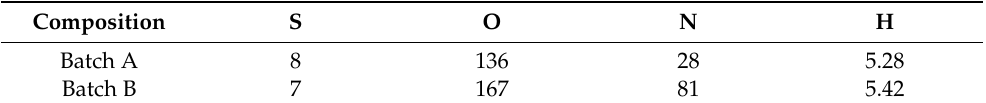
Table 3. Measured composition of the powders—trace elements (all measurements are in